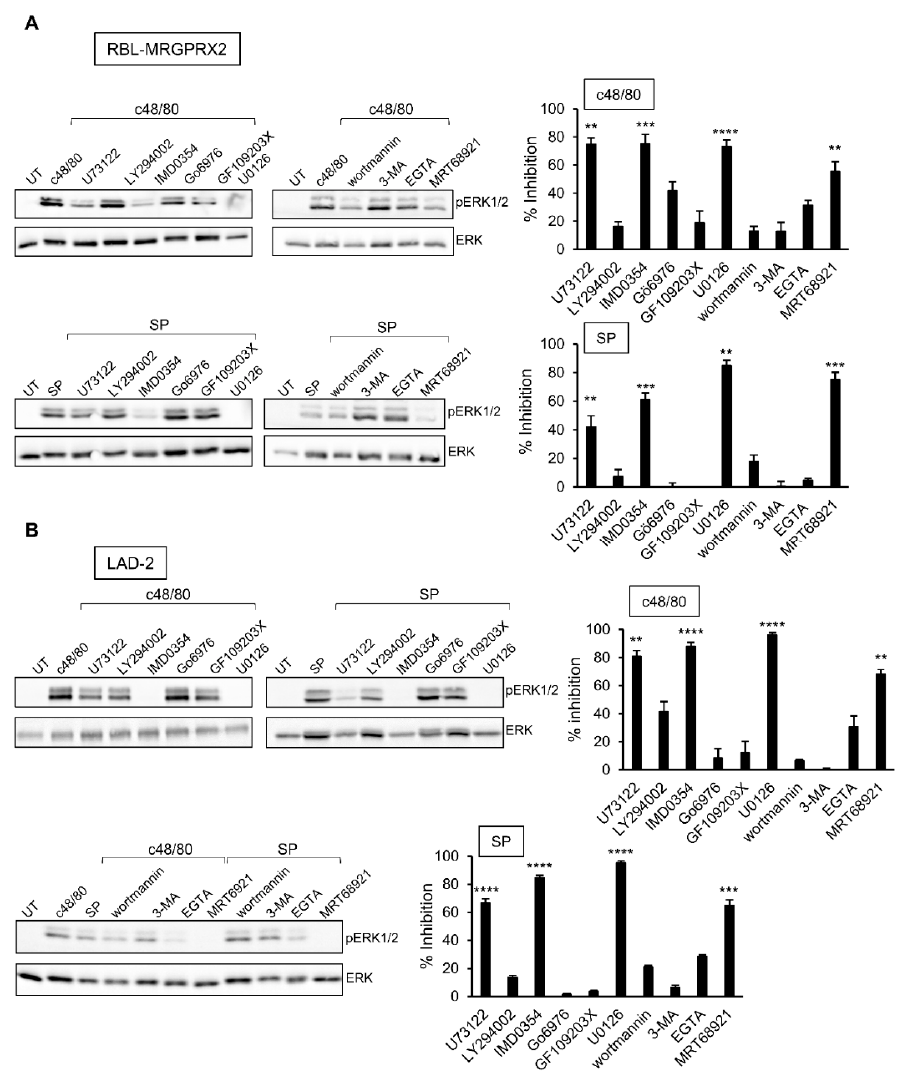
Figure 6. Inhibitor profiling of MRGPRX-2-stimulated ERK1/2 phosphorylation in LAD-2 and RBL-MRGPRX2 cells reveals similar patterns of drug sensitivity. RBL-MRGPRX2 ( A ) and LAD-2 ( B ) cells (1 × 10 6 cells/mL) were incubated for 30 min, at 37 ◦ C, with vehicle or 10 µ M U73122, 10 µ M LY294002, 0.5 µ M IMD0354, 1 µ M Go6976, 1 µ M GF109203X, 10 µ M U0126, 50 µ M wortmannin, 5 mM 3-MA, 1 µ M MRT68921 or 2 mM EGTA, as indicated. Cells were then stimulated by either 1 µ g/mL c48/80 or 10 µ M SP for 1 min. Cell lysates were resolved by SDS-PAGE and immunoblotted with anti-pERK1/2 antibodies, followed by reprobing with anti-total-ERK2 antibodies, as indicated. The intensities of the bands corresponding to phospho-ERK1/2 and total ERK2 were quantified by densitometry, using Image-J software, and the relative pixel densities (phosphorylated/total) were calculated. Results are presented as percent of inhibition. Data are the means ± SEM (n = 3–6). Statistical significance was determined by one-way ANOVA, followed by Dunnett’s post-test (** p < 0.01, *** p < 0.001, **** p < 0.0001). Representative blots are